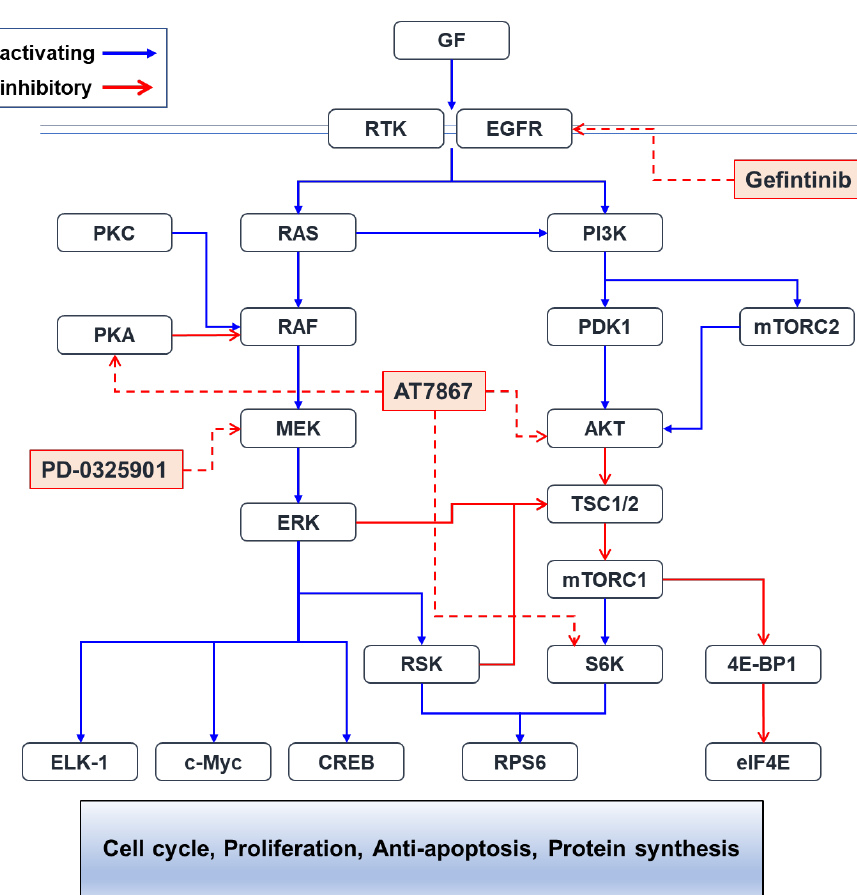
Figure 10. Putative Pathways affected by small-molecule inhibitors in this study. The PI3K/AKT/mTORC1 and RAS/RAF/MEK/ERK pathways cross-talk each other. Small-molecule PKIs used in this study would inhibit their target molecules, which results in synergistic anti-cancer effects. Abbreviations: 4E-BP1, eukaryotic initiation factor 4E-binding protein 1; AKT, v-akt murine thymoma viral oncogene homolog; c-Myc, cellular myelocytomatosis; CREB, cAMP responsive element-binding protein; EGFR, epidermal growth factor receptor; eIF4E, eukaryotic translation initiation factor 4E; ELK-1, E twenty-six (ETS) like-1; ERK, extracellular signal-regulated kinase; GF, growth factor; MEK, MAPK/ERK kinase; mTORC1/2, mammalian target of rapamycin complex 1/2; PDK1, 3-phosphoinositide-dependent protein kinase-1; PI3K, phosphoinositide 3-kinase; PKA, protein kinase A; PKC, protein kinase C; RAF, v-raf-1 murine leukemia viral oncogene homolog; RAS, rat sarcoma; RPS6, ribosomal protein S6; RSK, ribosomal S6 kinase; RTK, receptor tyrosine kinase; S6K, S6 kinase; TSC1/2, Tuberous sclerosis 1/2.